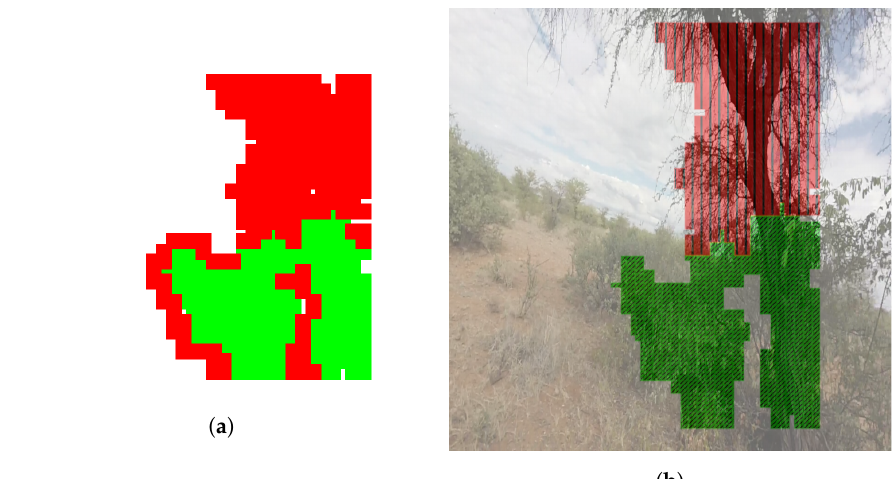
Figure 7. Final region of interest: ( a ) showing mapped search results and ( b ) demonstrating the region of interest after SLIC